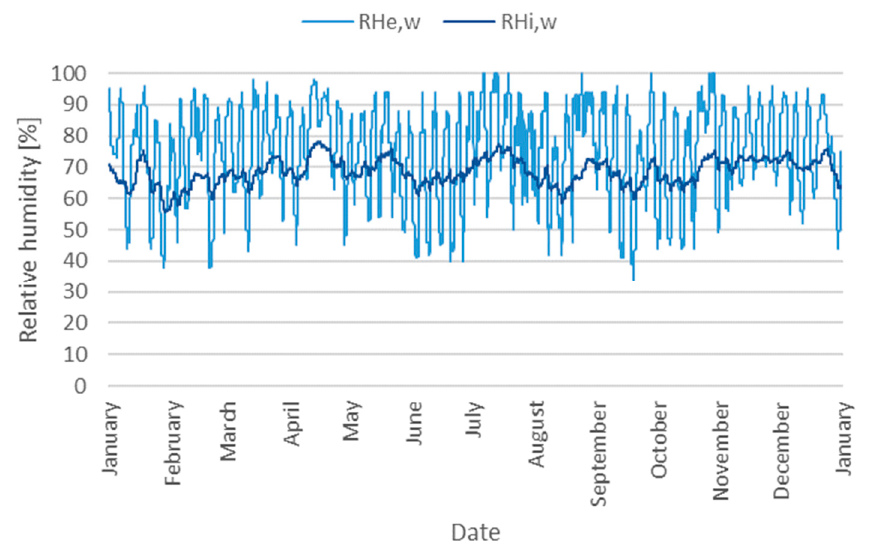
Figure 8. The course of the relative humidity of the internal (RH i,w ) and external (RH e,w ) air in an unheated church with a wooden floor.